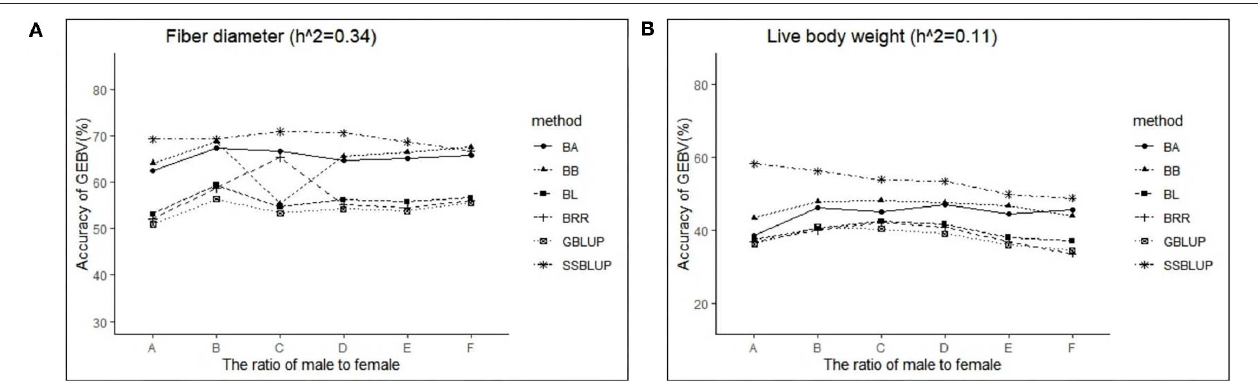
FIGURE 5 | The change trends of accuracy of GEBV with increasing ratio of males to females with GBLUP and Bayes methods.